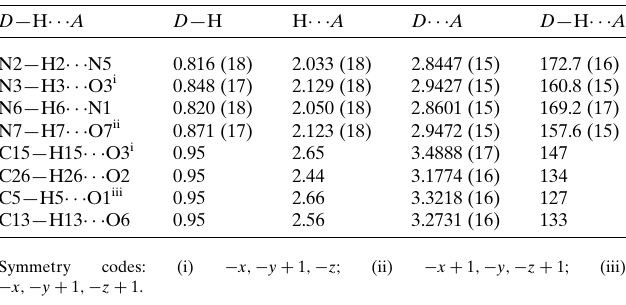
Table 2 Hydrogen-bond geometry (A˚ , (cid:4) ) for (II).